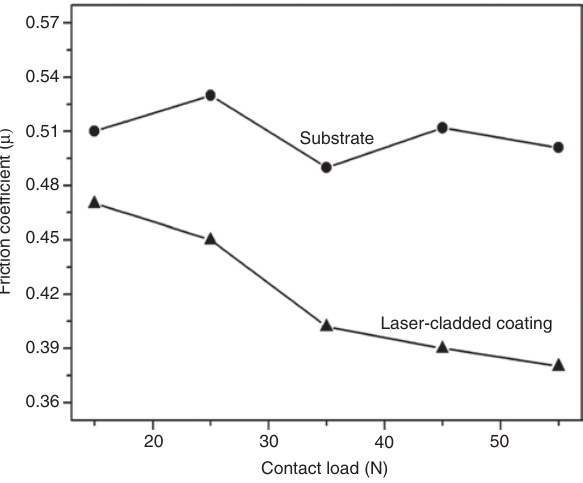
Al-B C-YPSZ- 3 4